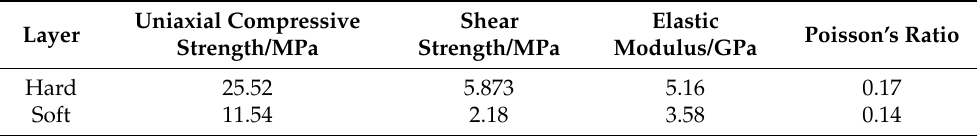
Table 2. The mechanical properties of artificial sandstone.